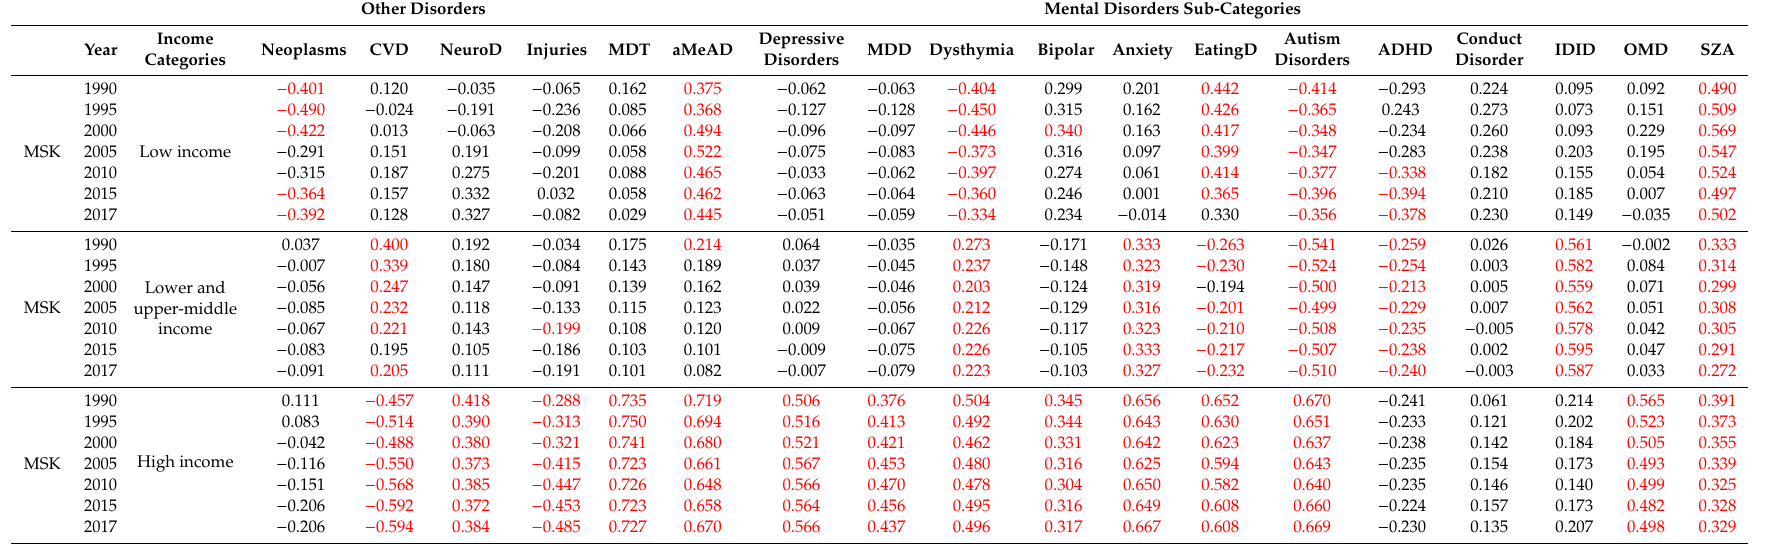
Table 4. Spearman’s correlation coe ffi cients between age-standardized DALYs attributed to musculoskeletal disorders and age-standardized DALYs attributed to various disorders, among 195 countries, in both sexes, by country’s income categorization for 1990 to